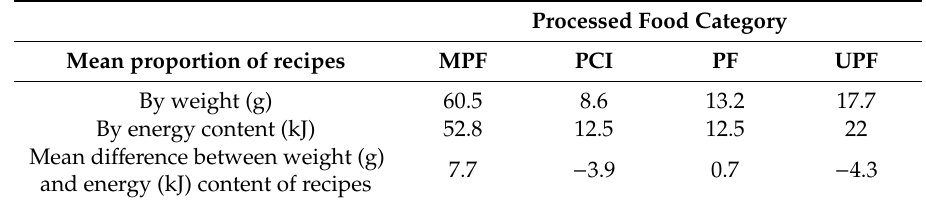
Table A1. Di ff erence in percentage weight (g) and percentage of energy (kJ) content by food processing, of ten randomly selected recipes from WDR 1